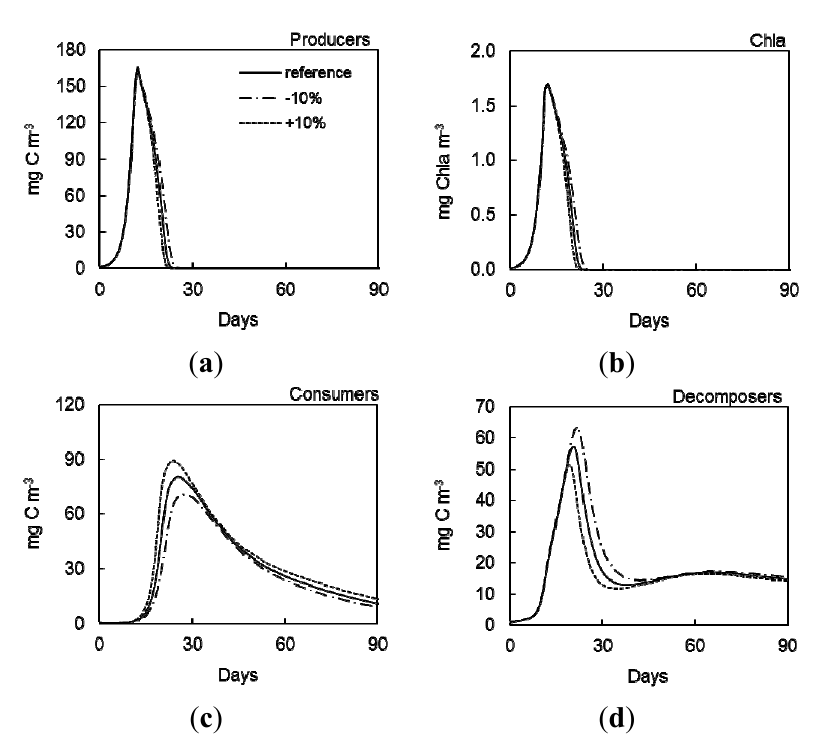
Figure 3. Temporal evolution of the response of ( a ) producers biomass; ( b ) chlorophyll a (Chla); ( c ) consumers biomass; and ( d ) decomposers biomass to the perturbation of assimil_effic